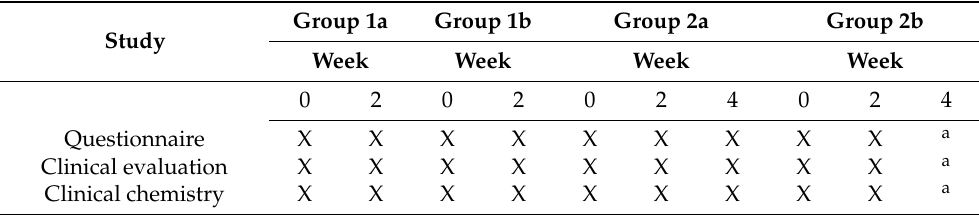
Table 2. Schedule of the procedures for the dogs that were included in the study population according to group.